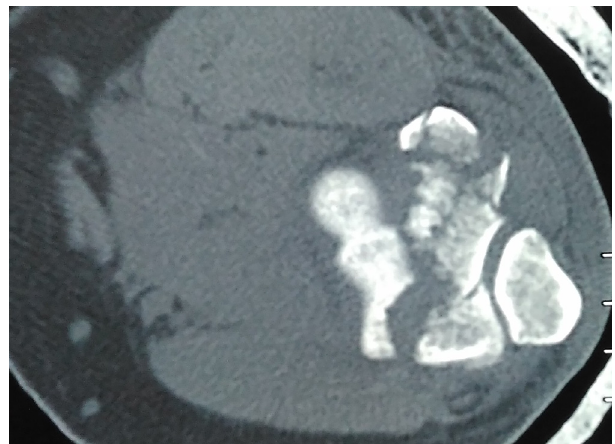
Figure 3. Axial Section CT scan showing a complex coronal plane fracture of distal humerus with posterior and lateral